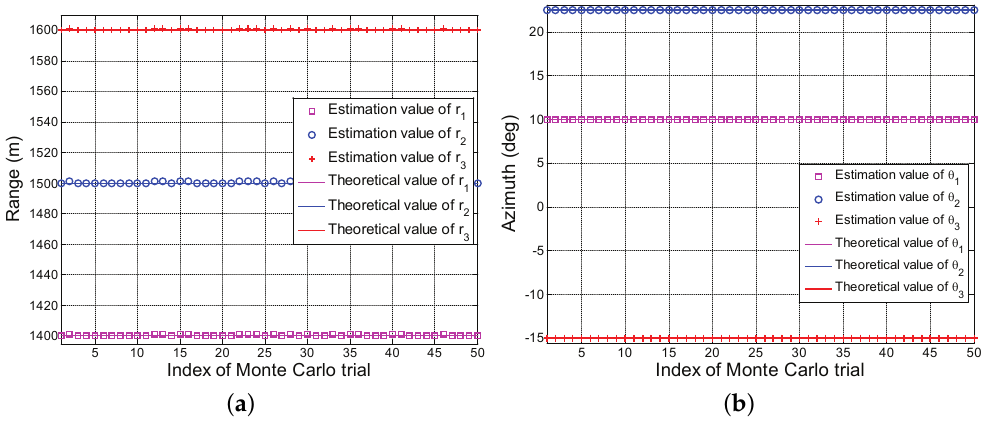
Figure 5. Estimation values of range and azimuth of calibration sources versus different Monte Carlo trials, ( a ) range; ( b ) azimuth.